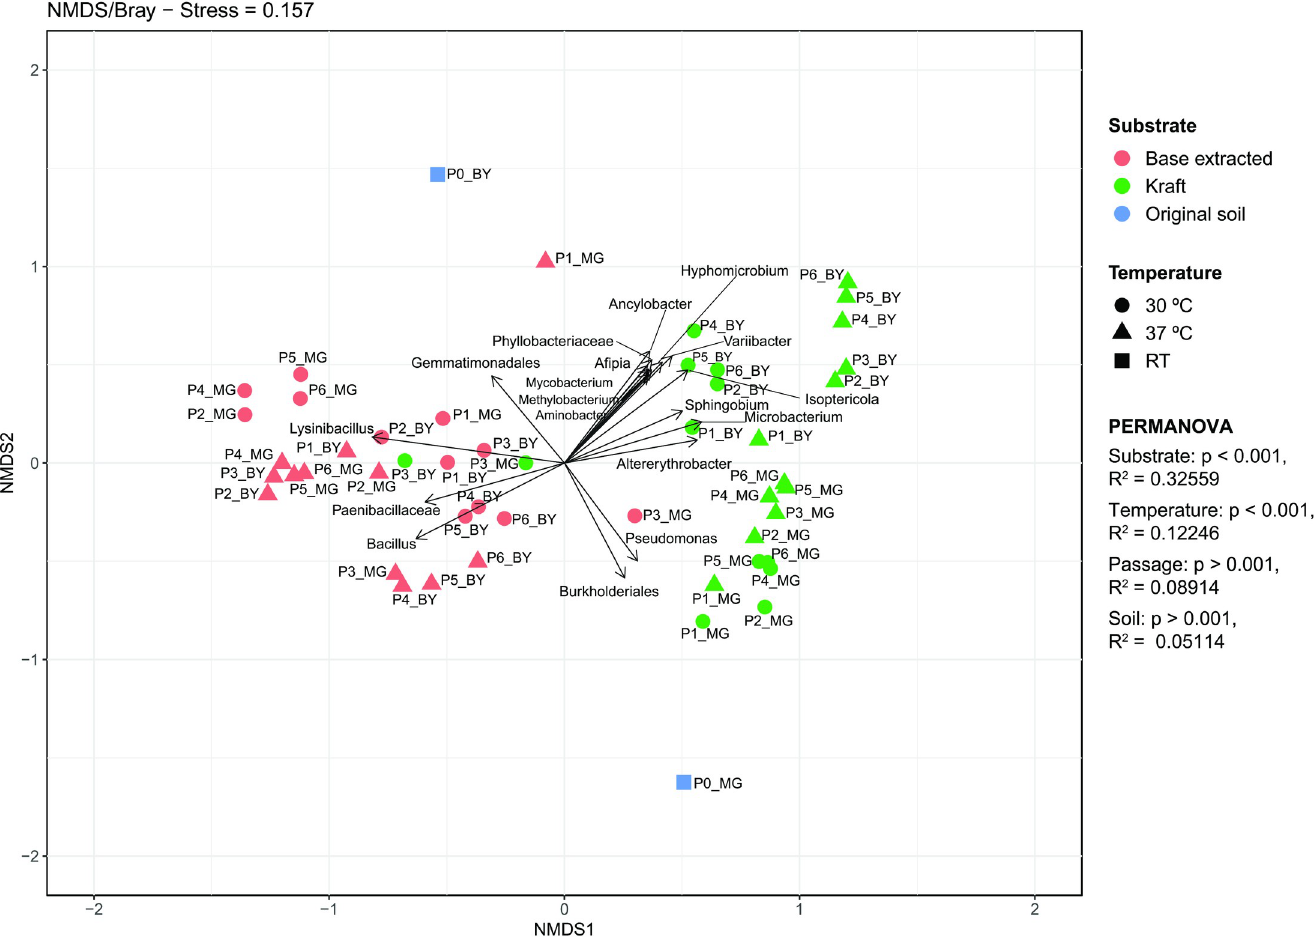
Fig 5. Bray-Curtis analysis of dissimilarity in the non-metric multidimensional scaling matrix (NMDS) to consortia composition at genus level in relation to the variables type of lignin used as carbon source and temperature. MG- and backyard (BY) compost derived consortia were analyzed. P0 refers to the original compost; “P1” to “P6” refer to the six passages (selection cycles); The stress number is given at the top. � Stress < 0.05 excellent, < 0.1 great, < 0.2 good and < 0.3